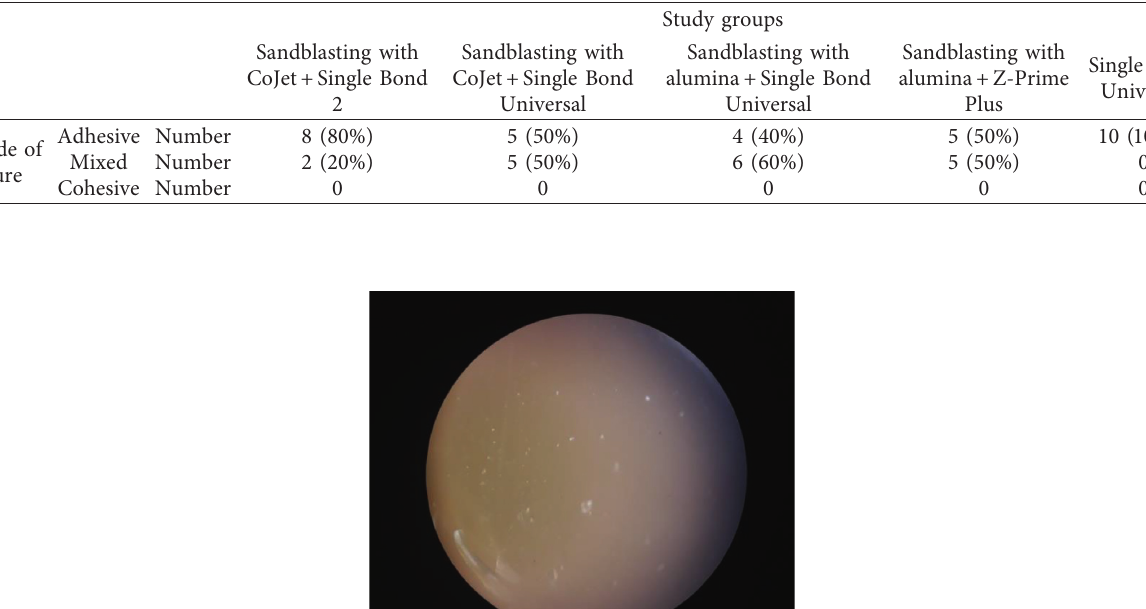
Figure 2: A specimen with adhesive failure under stereomicroscope